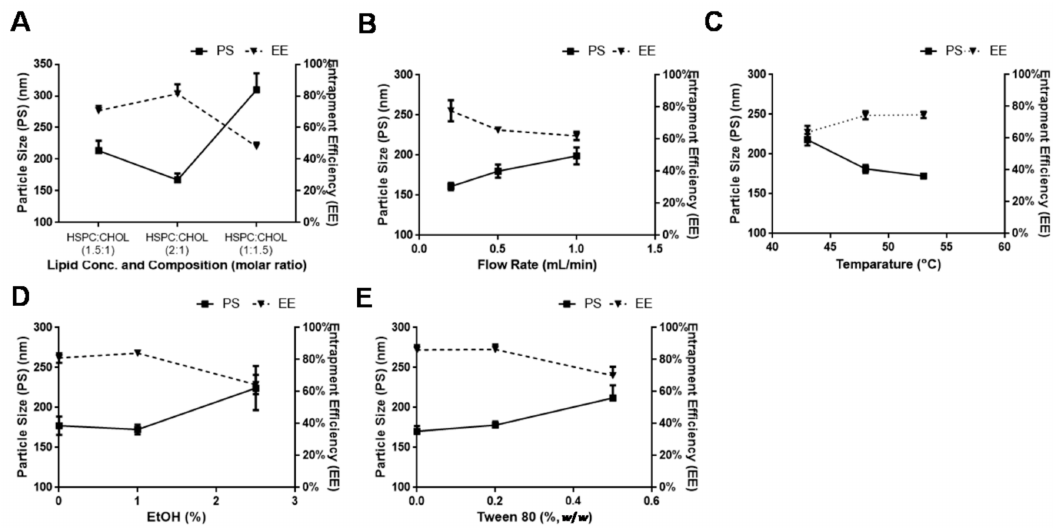
Figure 1. Effect on colloidal system regarding particle size (PS) and entrapment efficiency (EE) of process variables ( A ) Lipid concentration and composition, ( B ) flow rate, ( C ) Temperature, ( D ) Ethanol, ( E ) Tween